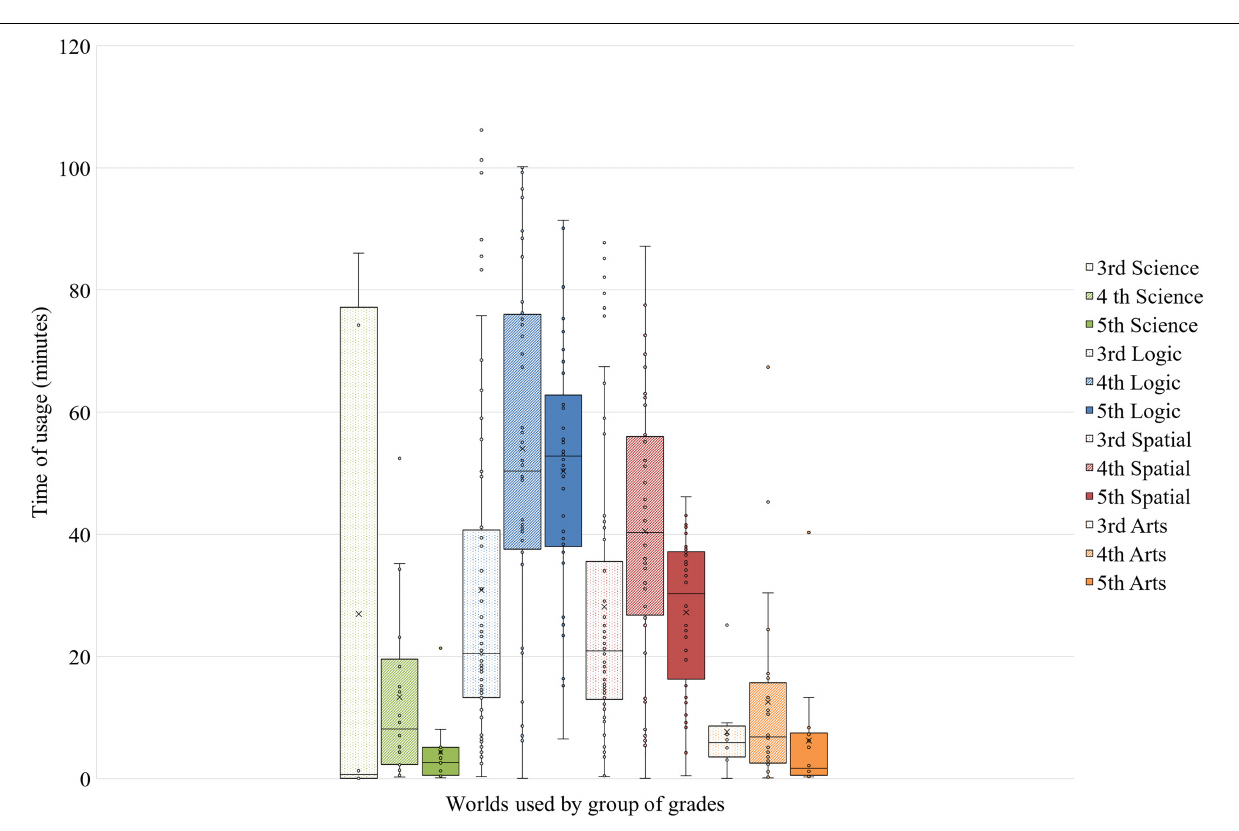
FIGURE 3 | Graphic of descriptive statistical by grades of time of use in Science, Logic, Spatial, and Arts.